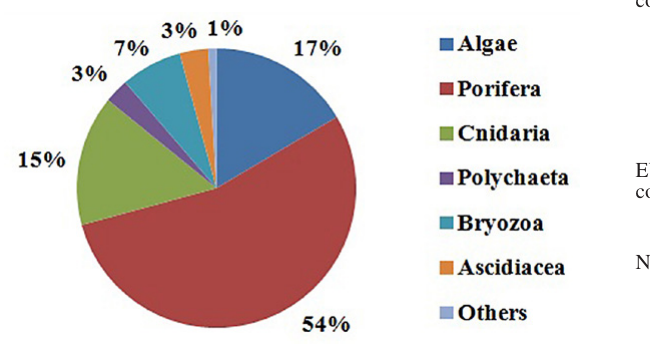
Fig. 2. – Taxonomic composition of coralligenous sessile megab- enthos in Liguria.